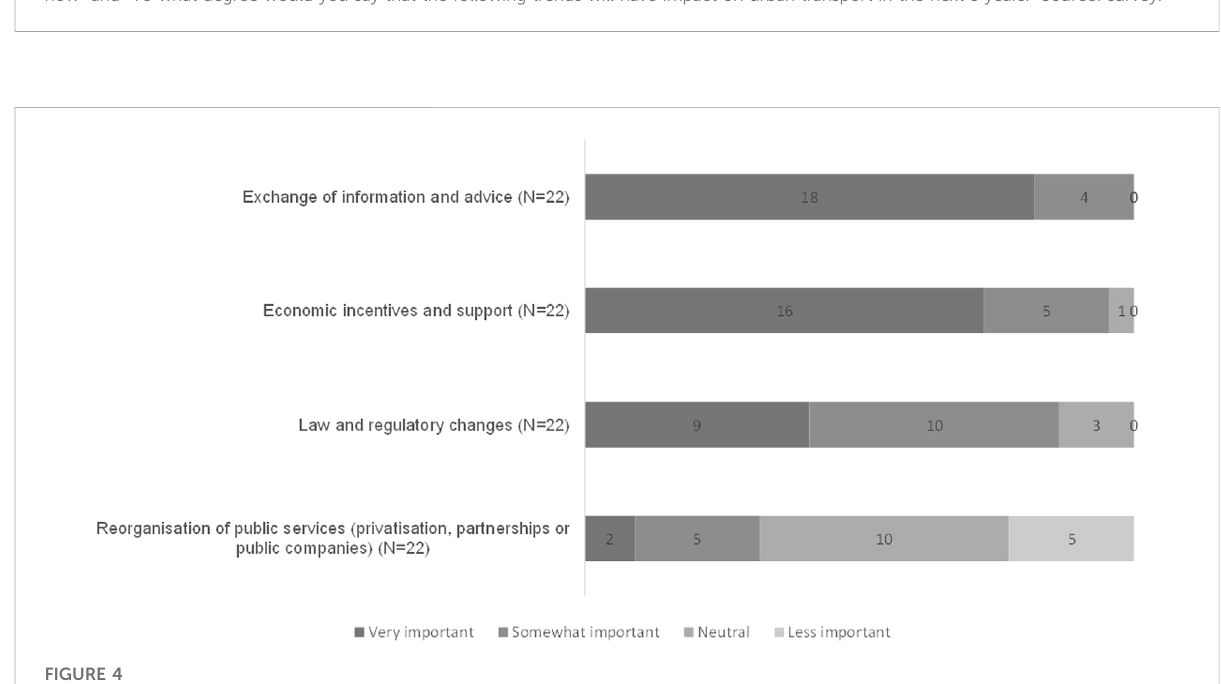
FIGURE 4 Statements concerning role of public sector. Source: